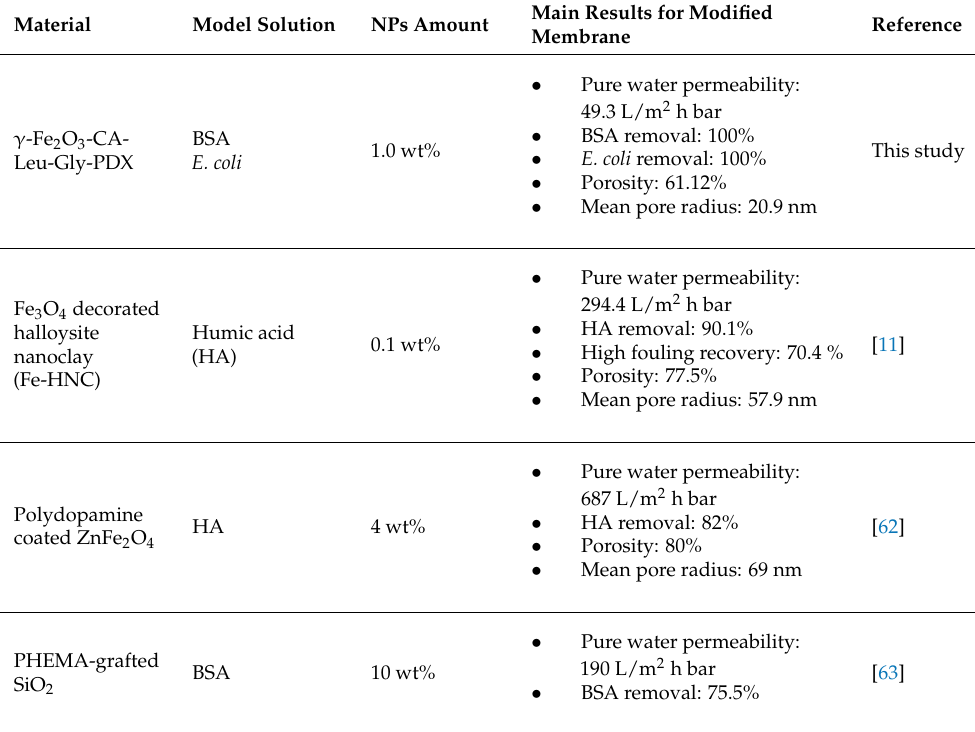
Table 3. Performance comparison of PES membranes blended with different